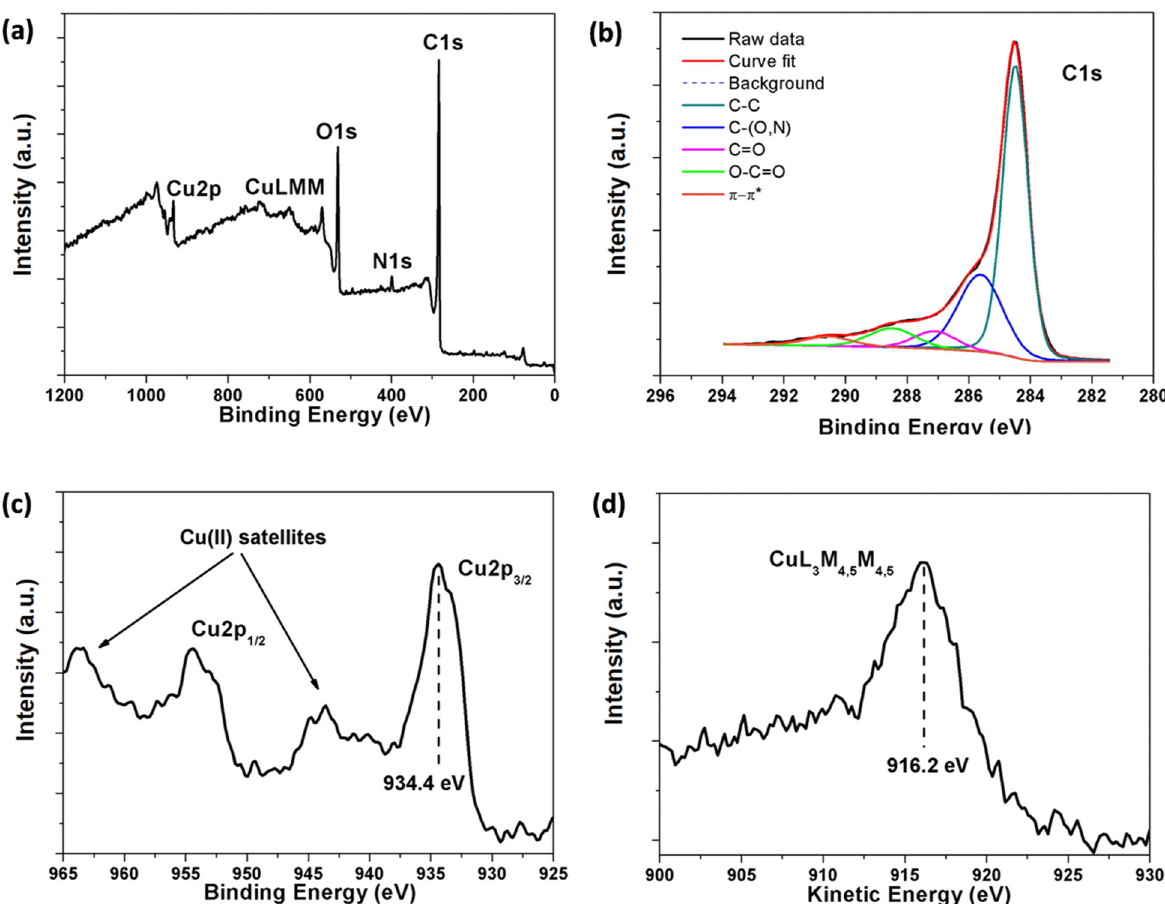
Fig. 2 XPS characterization of Cu-N-rGO sample. a Survey spectrum, b C 1s HR spectrum with deconvolution procedure, c Cu 2p HR doublet and d CuLMM Auger